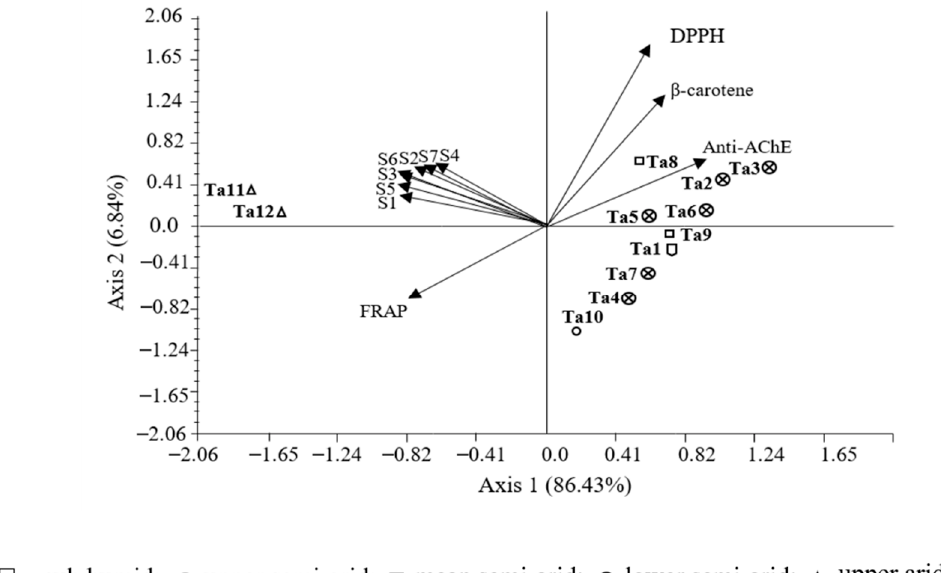
Figure 3. Plot of the principal component analysis performed on values of antioxidant, anti-acetylcholinesterase, and antibacterial activities. Ta 1–Ta 12 correspond to the code number as detailed in Table 1. DPPH • , β -carotene, FRAP: antioxidant assays. S1: E.coli , S2: P. aeruginosa, S3: K. pneumoniae , S4: S. aureus , S5: B. cereus , S6: S. epidermis , S7: S.